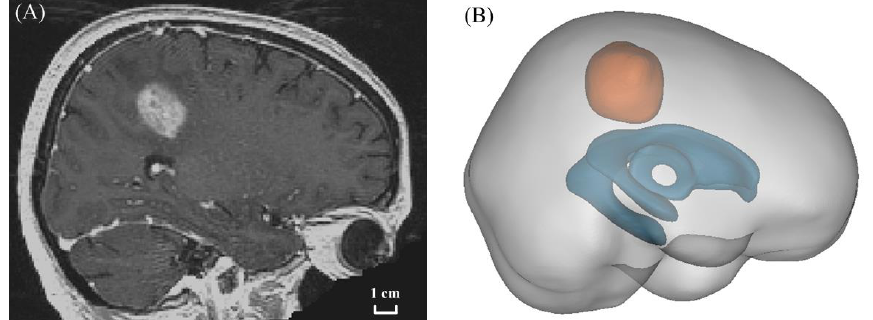
Figure 3. Model geometry. ( A ) MR image, and ( B ) reconstructed 3D geometry of brain tumour (orange) and its surrounding normal tissue (grey). The brain ventricle is coloured in cyan.